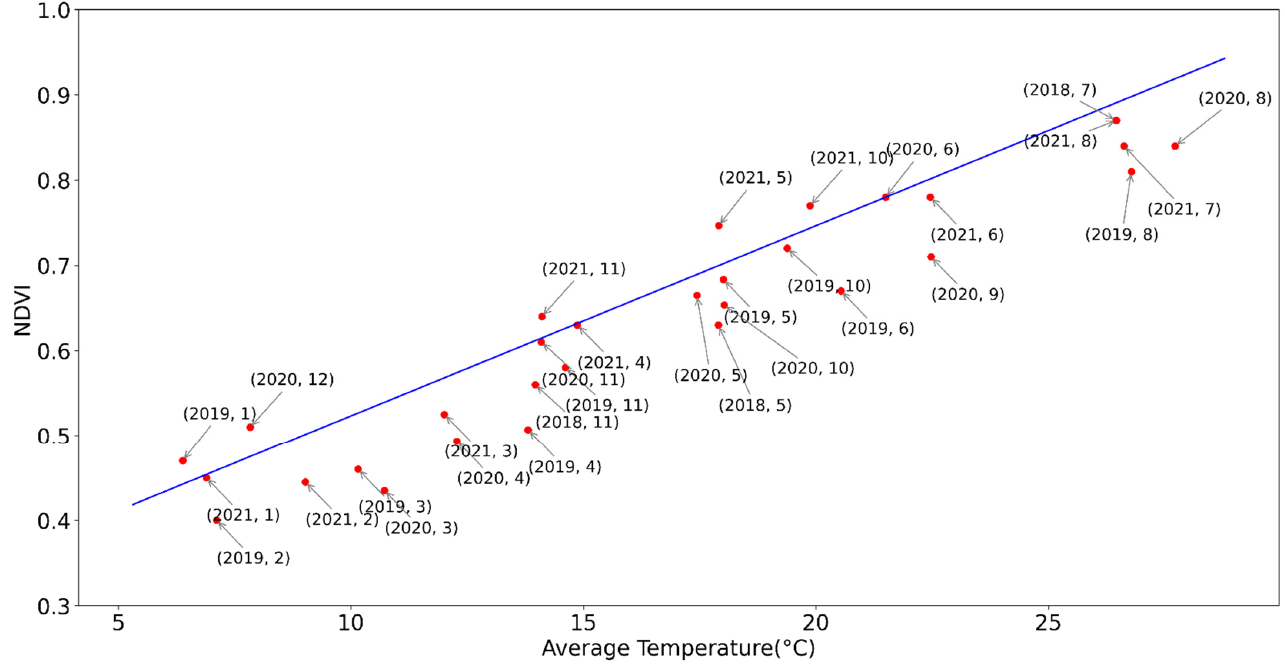
Figure 5. The chart of fitted model where the numbers in parentheses mean the year and month.